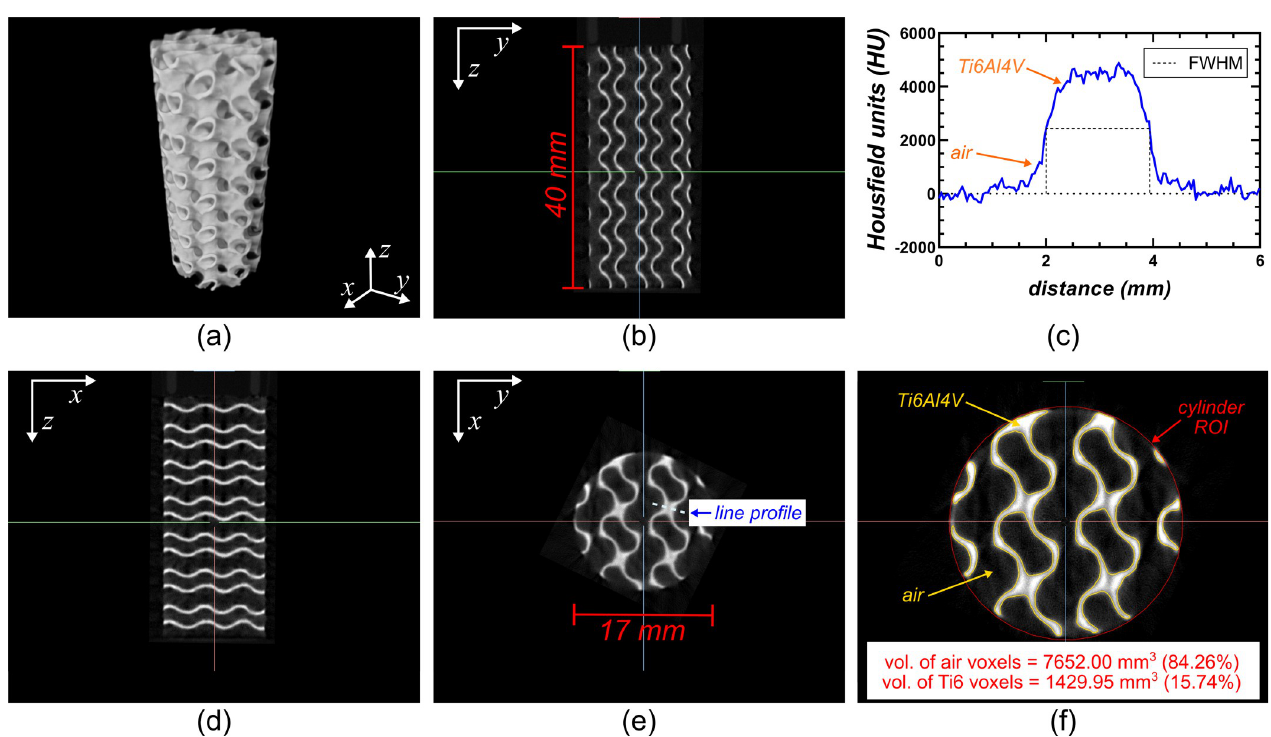
Fig 15. CT reconstruction of the porous gyroid-based cylindrical titanium-alloy (Ti6Al4V) scaffold using the cost-effective CT scanner. (a) perspective view of volumetric rendering using the FWHM threshold used to segment titanium. (b) Trans-coronal slice CT reconstruction of the porous cylinder. (c) Signal profile across a wall of the porous cylinder used to determine the FWHM threshold for segmentation. (d) Trans-sagittal slice CT reconstruction of the porous cylinder. (e) Transaxial slice CT reconstruction of the porous cylinder and line profile used for (c). (f) close-up version of (e) illustrating boundaries between the titanium and air ROIs used to measure the porosity of the porous, cylindrical, titanium scaffold.